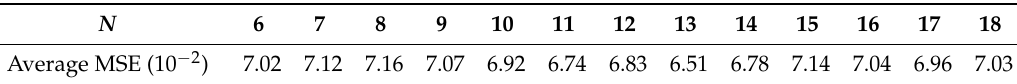
Table 2. Training results of network with different number of hidden layer